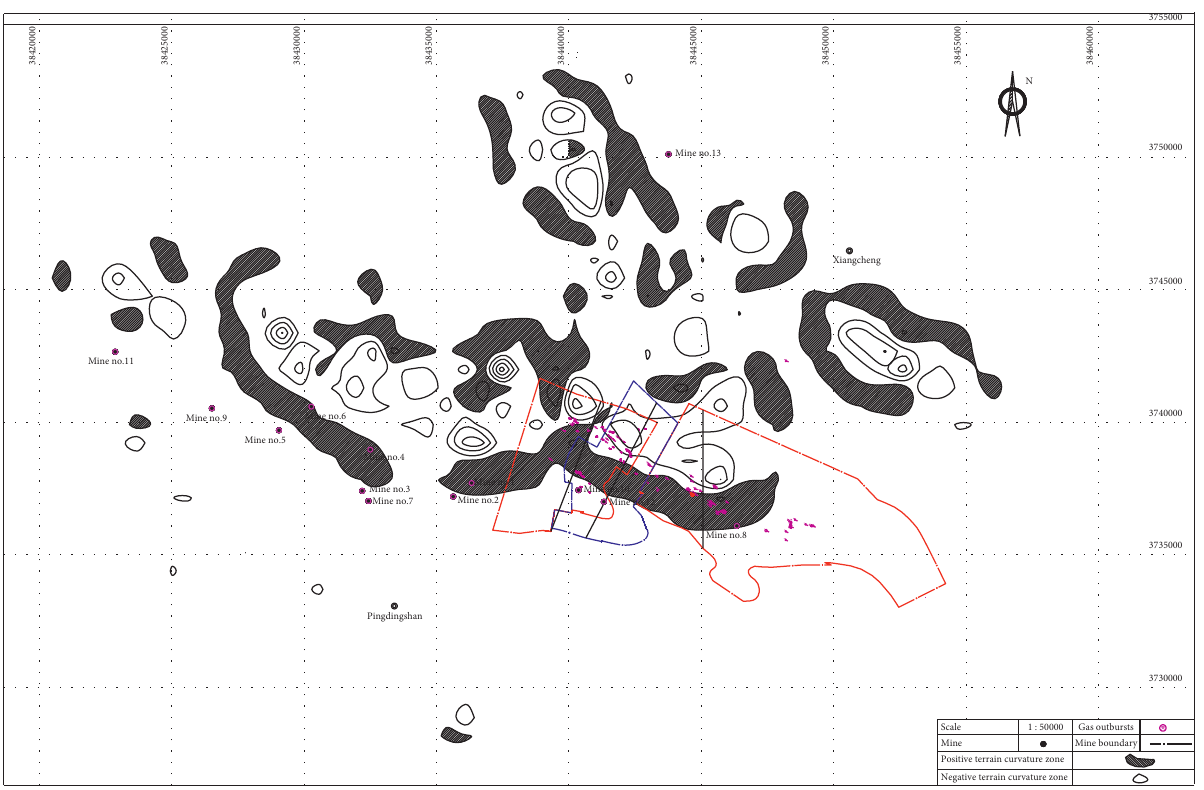
Figure 4: Terrain curvature change diagram for the Pingdingshan mine.